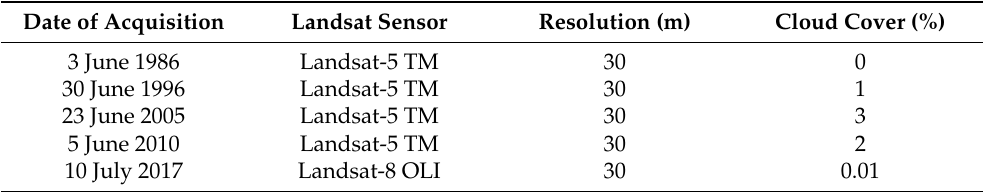
Table 1. List of Landsat satellite images used in this study with acquisition dates, sensor type, resolutions, and cloud